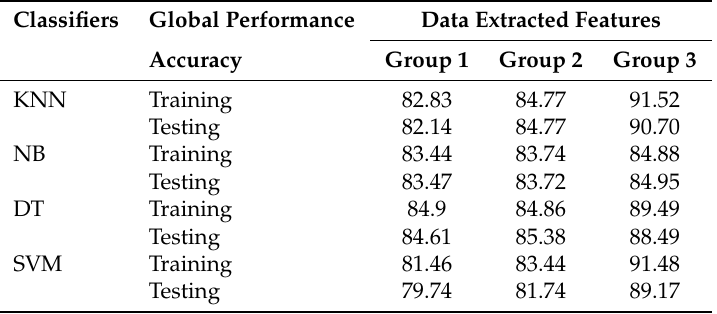
Table 9. Accuracies of extracted features based PCA with different